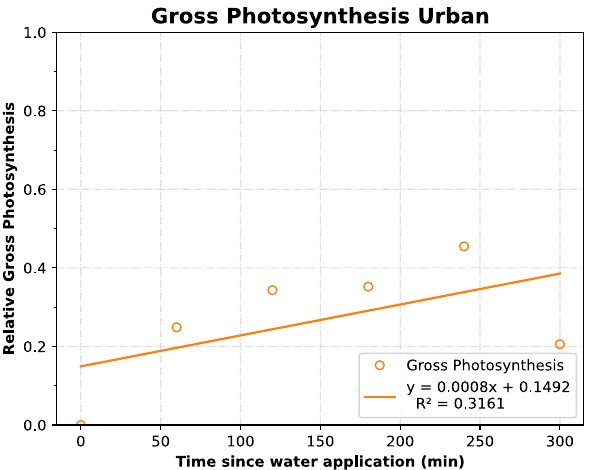
Figure 3. Urban gross photosynthetic rate over time, normalized to the maximum rate.